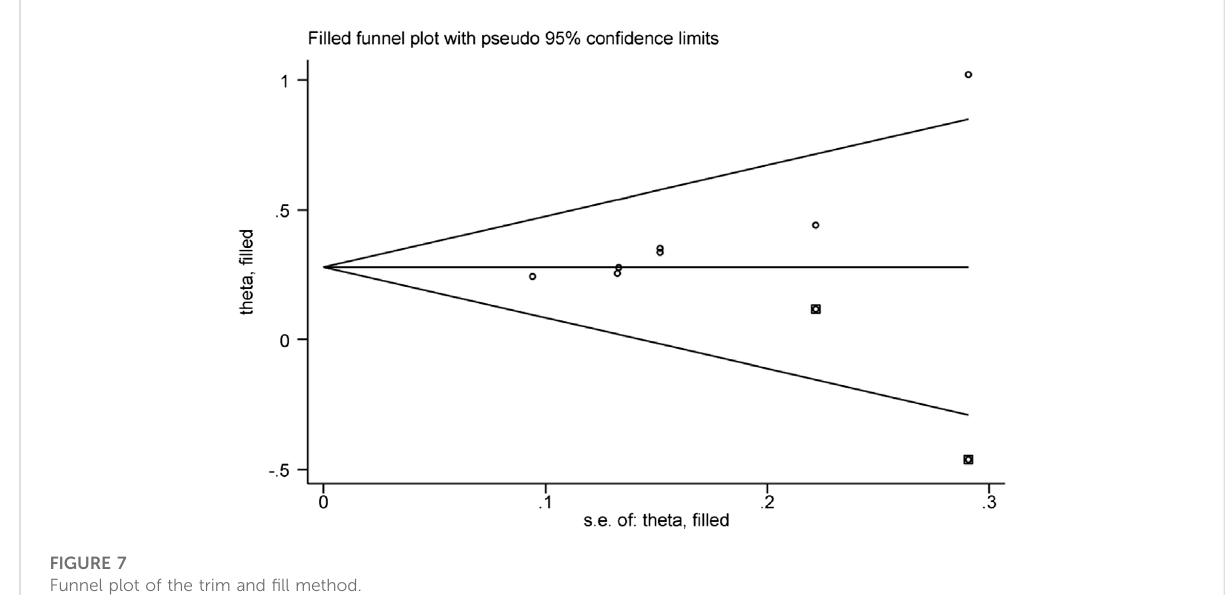
FIGURE 7 Funnel plot of the trim and fi ll method.